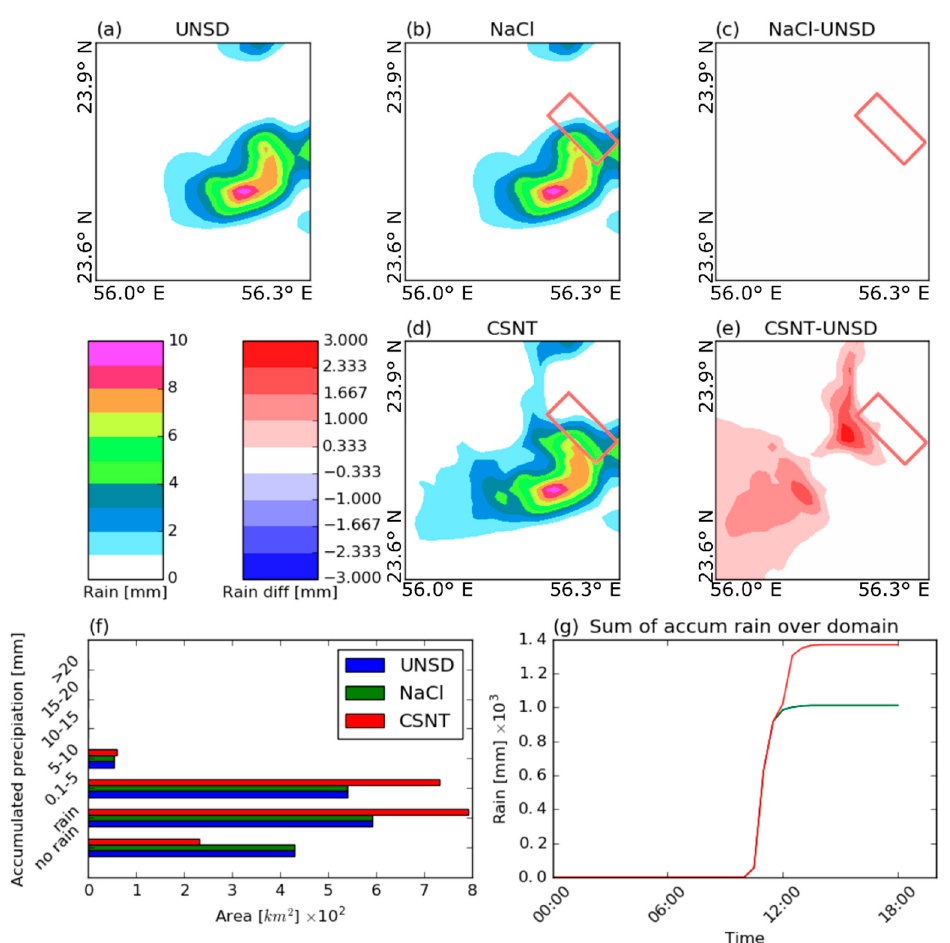
Figure 8. Spatial distribution of accumulated precipitations for the arid case of the UAE for ( a ) the unseeded case (UNSD), ( b ) core/shell sodium chloride (NaCl) and ( d ) sodium chloride (NaCl)/titanium dioxide (TiO 2 ) nanostructure (CSNT) cases. The red rectangle shows the seeding region. The differences between the accumulated precipitation in the cases shown in panels ( c ) and ( e ). ( f ) Bar plot of areas characterized with different intensities of accumulated precipitations. ( g ) Time histories of accumulated precipitation in the UNSD (blue), NaCl (green) and CSNT (red) cases.